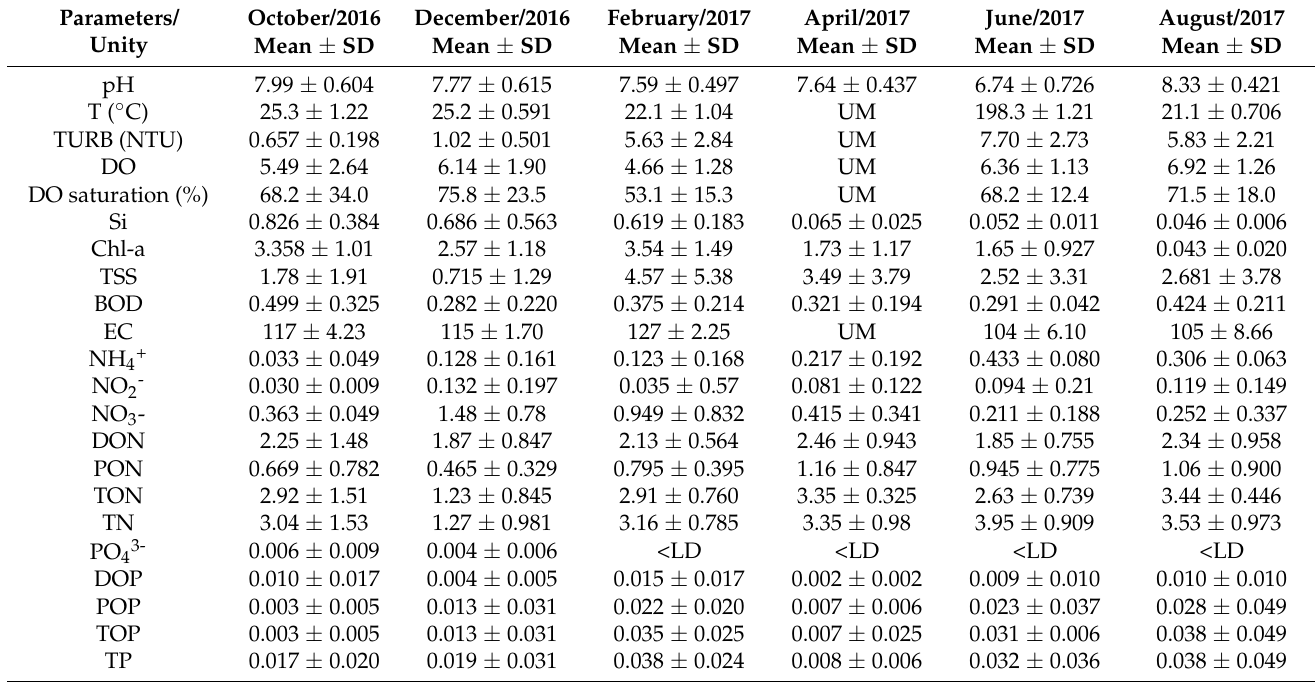
Table 2. Mean and standard deviation values of water quality parameters among sampling months at Lake Parano á Reservoir, including wet and dry seasons. Except for T ( ◦ C), turbidity (NTU), Chl-a ( µ g L − 1 ), DO saturation (%). and EC ( µ S cm − 1 ), the rest are in mg L − 1 . UM, unmeasured; LD, detection limit.